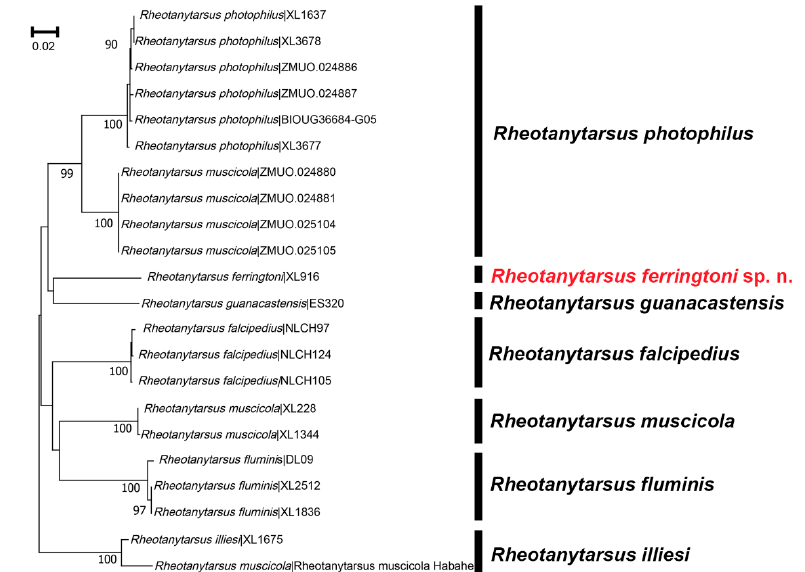
Figure 2. Neighbor-joining tree for seven species of the Rheotanytarsus muscicola species group based on K2P distance in DNA barcodes. Numbers on branches represent bootstrap support (>70%) based on 1000 replicates; scale equals K2P genetic distance.